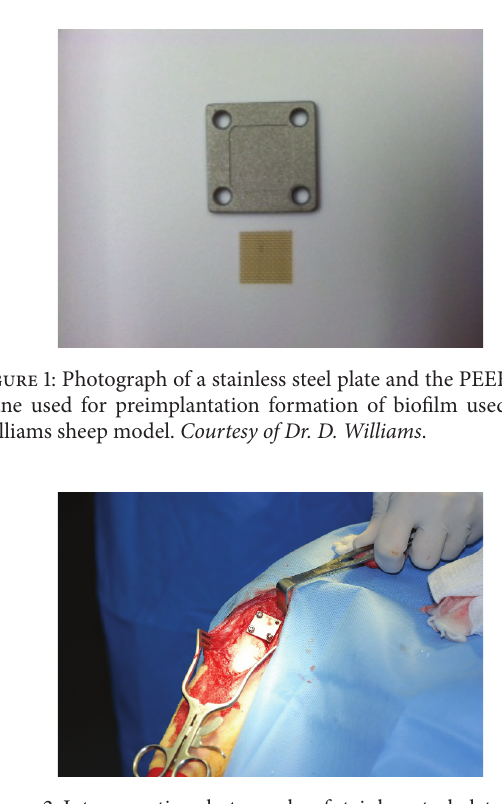
Figure 2: Intraoperative photographs of stainless steel plates placed in the proximal tibia used in the Williams et al. sheep model. Courte- sy of Dr. D. Williams